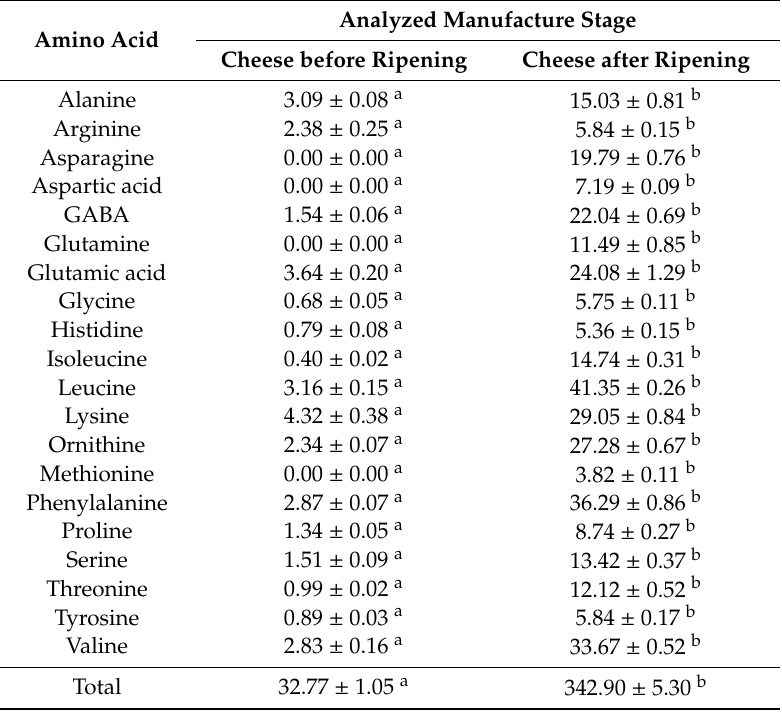
Table 4. Amino acid composition (mg / 100 g dw) between two stages of Feta-type cheese ripening. Analyzed Manufacture Stage Amino Acid Cheese before Ripening Cheese after